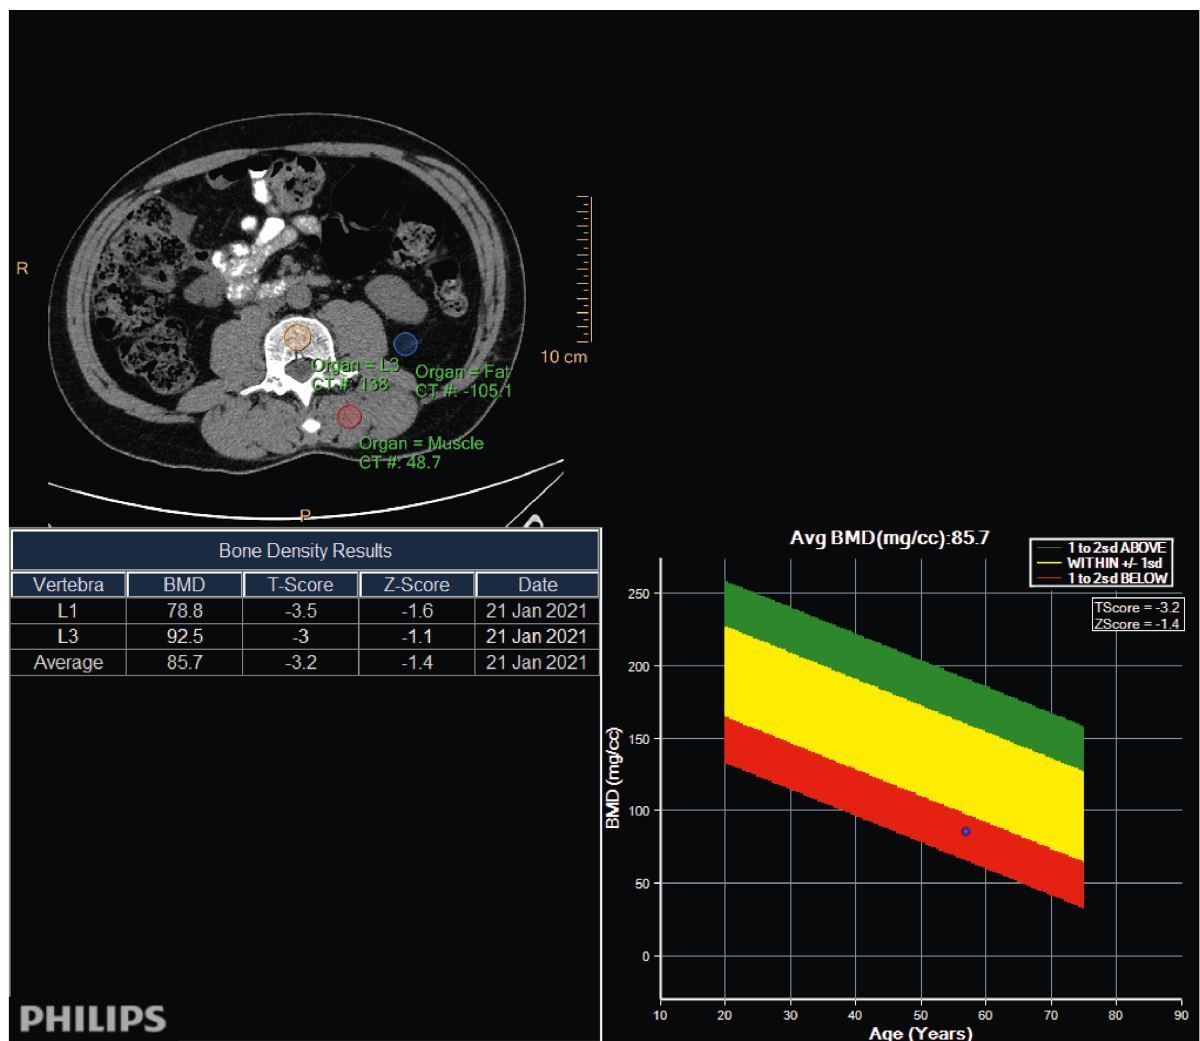
Figure 1: Philips bone mineral density application. An anonymised male patient selected from the PACS database at Kalafong Provincial Tertiary Hospital analysed on ISP using the bone mineral analysis application. The result shows a patient with osteoporosis (bone mineral density of 85.7, T score − 3.2, and Z score −